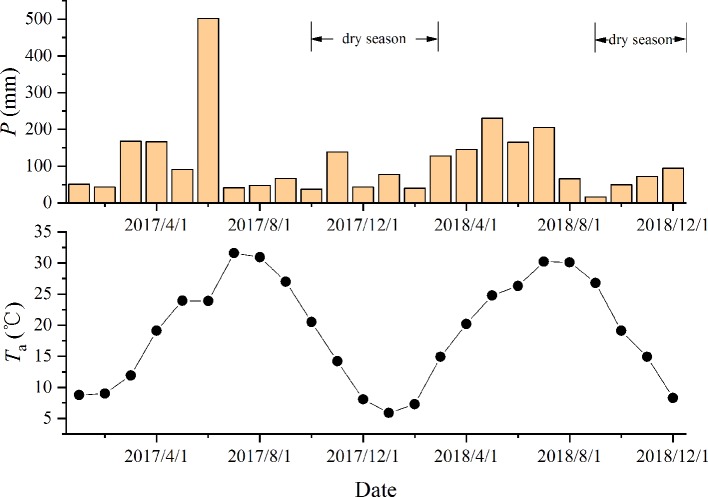
The dynamics of the monthly precipitation (P, mm) and mean temperature (T
a) during the period (2017.1–2018.12). Data were obtained from the National Meteorological Information Center (http://data.cma.cn).